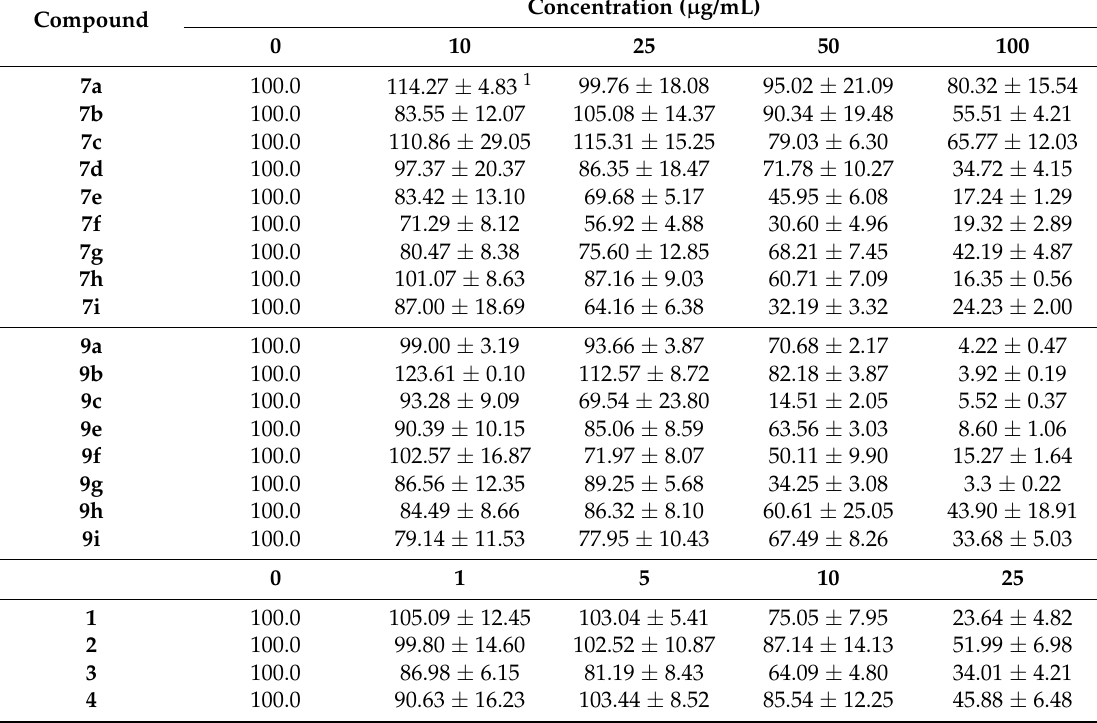
Table 2. Cell viability of RAW 264.7 cells after treated with various concentrations of halo-substituted